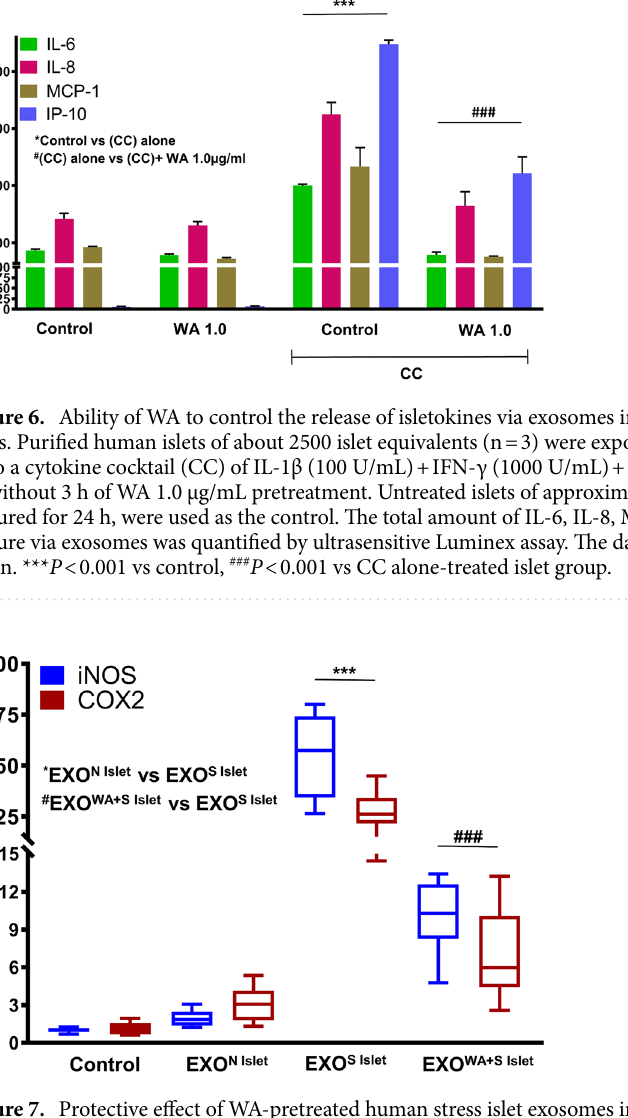
Figure 7. Protective effect of WA-pretreated human stress islet exosomes in the activation of human macrophages. Approximately 1 µg exosomes isolated from normal islets after 24 h of culture (EXO N Islets ), exosomes isolated from cytokine cocktail (CC)-induced stressed islets (EXO S Islet ), and exosomes isolated from WA 1.0 μg/mL-pretreated and CC-induced stressed islets (EXO WA+S Islet ) were used for activation of human macrophages (THP cells), cultured for 6 h. The relative intracellular mRNA expression of iNOS and COX-2 was quantified by quantitative polymerase chain reaction. The data represent mean ± standard error of the mean. *** P < 0.001 compared to EXO N Islets , ### P < 0.001 compared with EXO S Islets